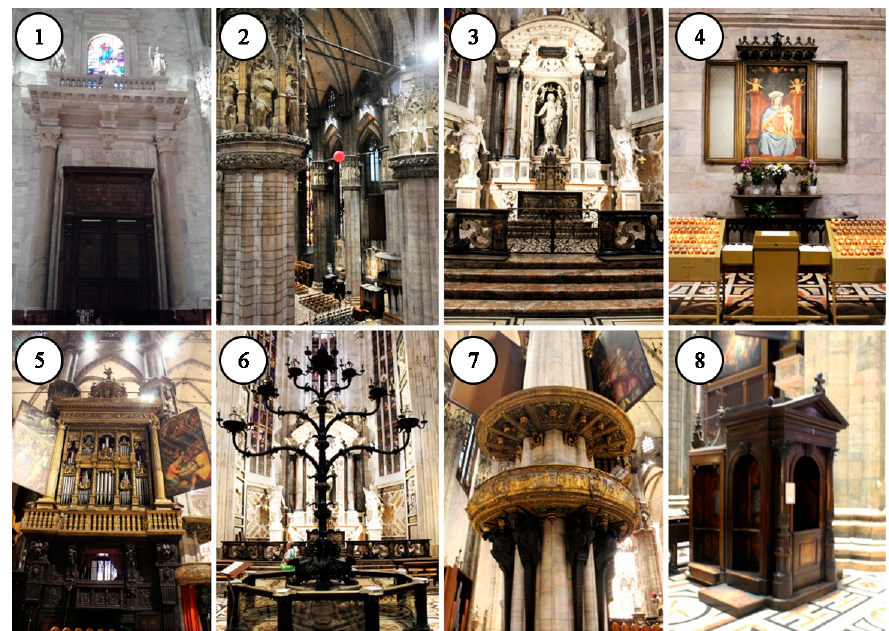
Figure 5. Some of the artworks of the Duomo di Milano. ( 1 , 2 ) shows stone sculptures; ( 3 , 4 ) shows various artefacts located in altars of the aisles; ( 5 ) shows one of the organ cases which has large wooden panels painted; ( 6 ) shows a bronze candelabrum with a marble base; ( 7 ) shows a pulpit made with bronze caryatids and balcony with gilded copper balusters; ( 8 ) shows a wooden